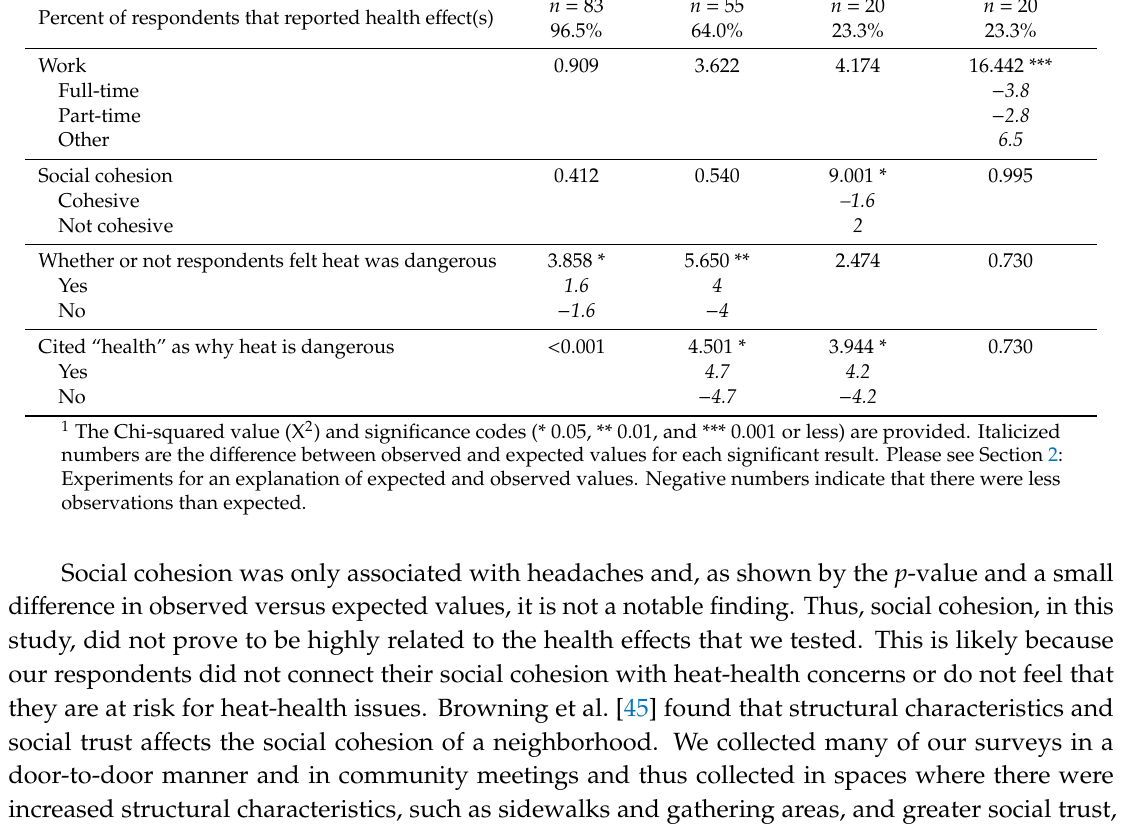
Table 4. Percent of respondents that reported health e ff ects and Chi-squared results for the associations between reported heat-health e ff ects and personal characteristics and perceptions ( n = 85) 1 . Dehydration